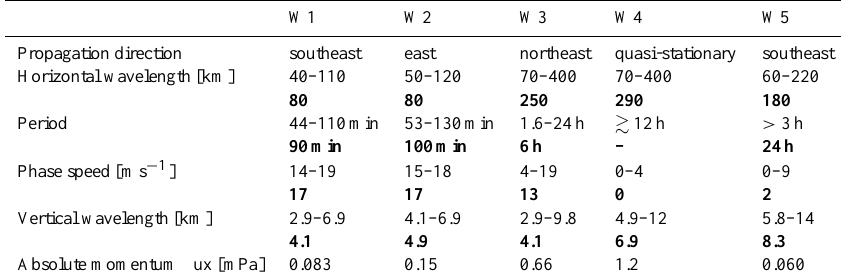
Table 1. Characteristics of the five groups of simulated gravity waves at z = 8km. The values in bold indicate the primary peaks obtained from the spectra for each characteristic. W1 W2 W3 W4 Propagation